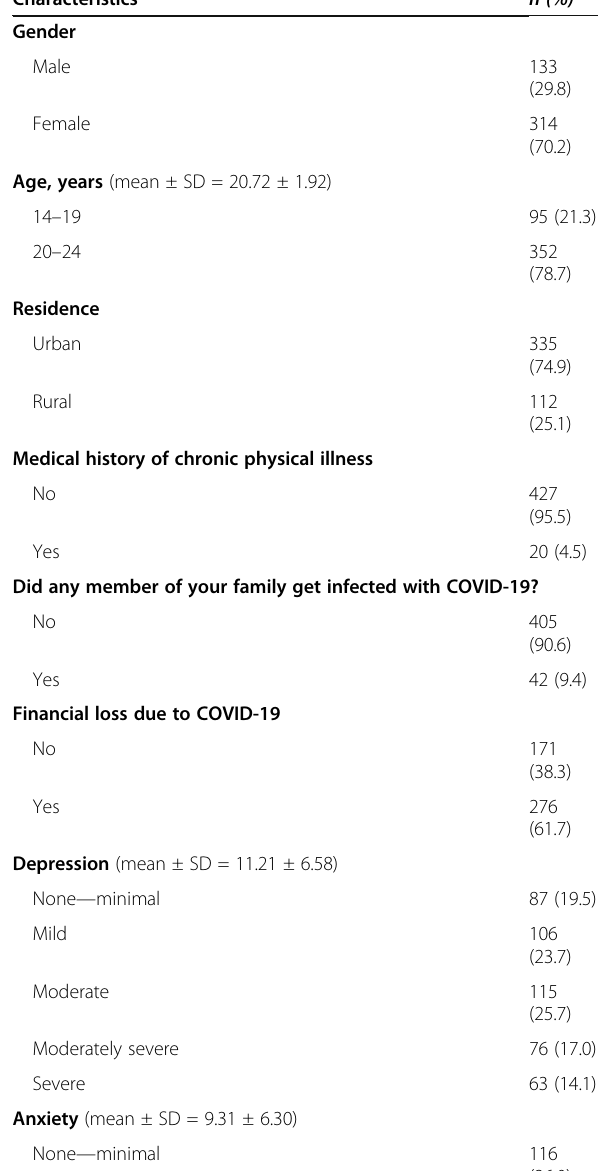
Table 1 Characteristics of the study participants ( n = 447)